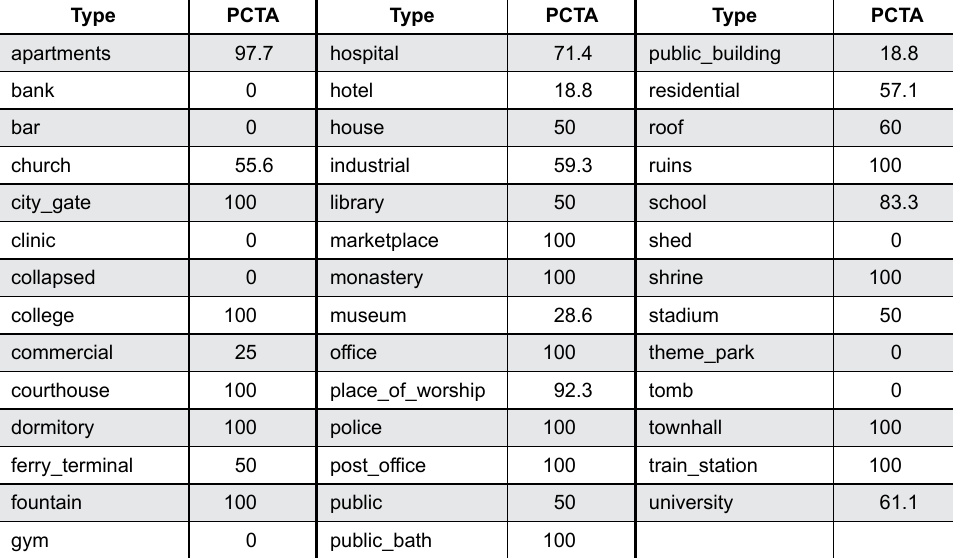
Fig. 6. Scatterplots of the position element Fig. 7. Scatterplots of the size element Table 5. The percentage of correct type assignment (PCTA) per OSM BF